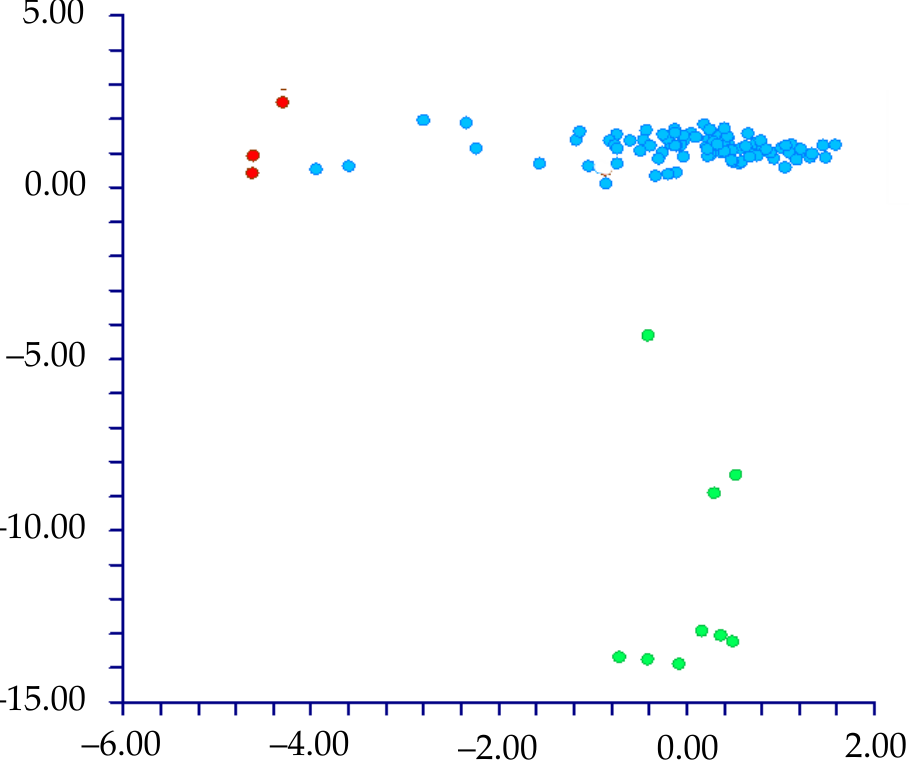
Figure 7. DA graph: [first (axis- x ) vs. second (axis- y ) component] performed on samples classified using Waselkov’s “molecular clades” [15] (nuclear genes).